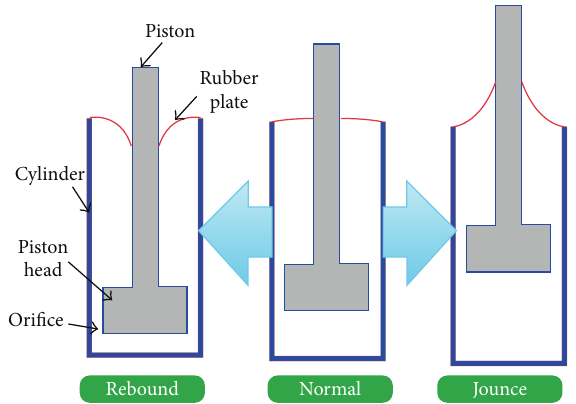
Figure 9: Configuration of new type of seal for integrated isolation mount.